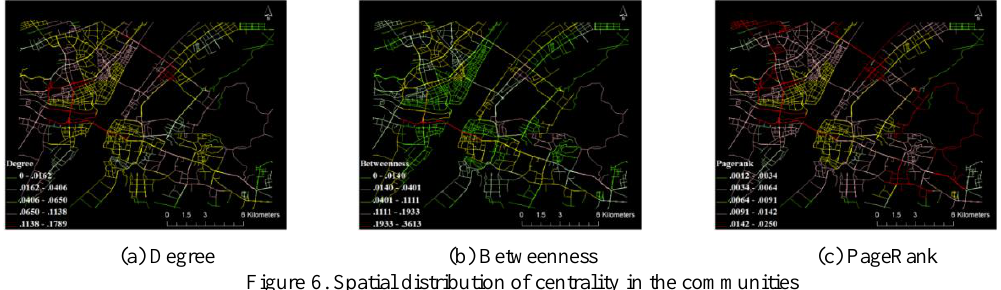
Figure 6. Spatial distribution of centrality in the